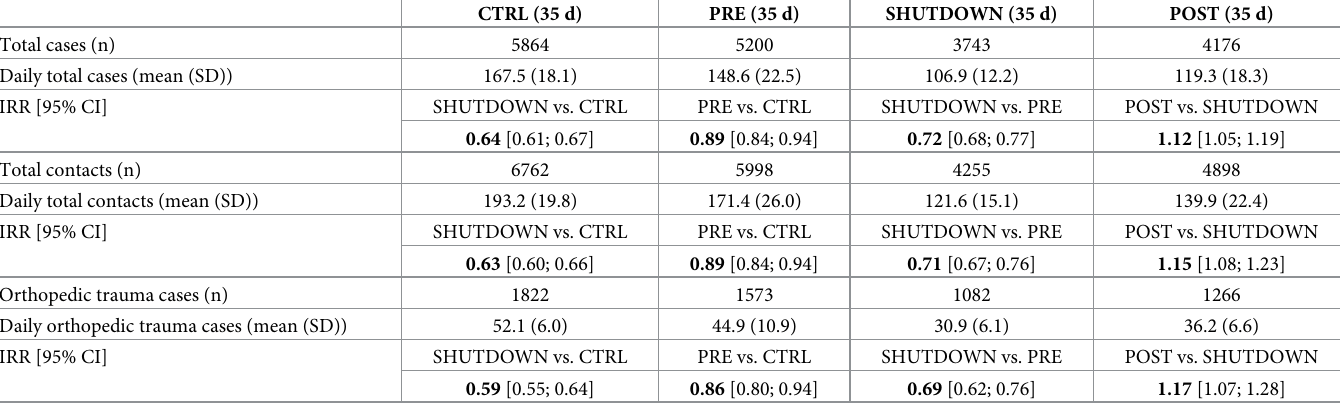
Table 1. Numbers (total and daily) of cases, contacts and orthopedic trauma cases as well as IRRs for the four defined periods (CTRL, PRE, SHUTDOWN, POST) before, during and after the COVID-19 shutdown in Berlin,